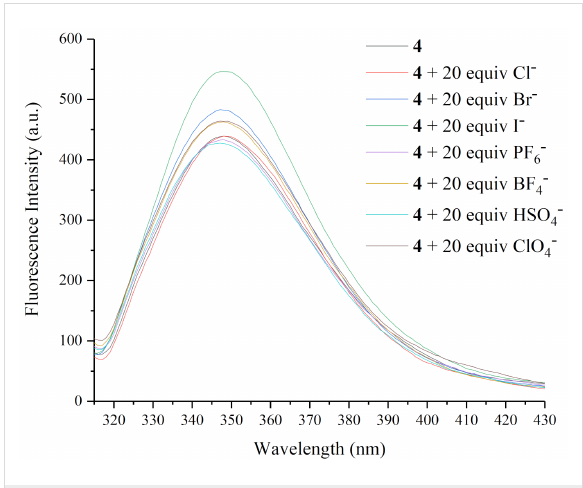
Figure 5: Fluorescence emission spectra ( λ max = 349 nm) of 4 (2.5 × 10 − 5 M) in the presence of 20 equivalents of Cl − , Br − , I − , PF 6 − , BF 4 − , HSO 4 − , ClO 4 − (5 × 10 − 4 M) in CH 2 Cl 2 /CH 3 OH 4:1 (v/v) at 298 K.